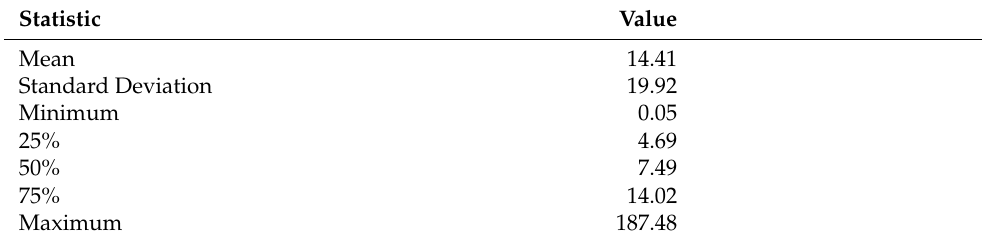
Table 4. Description of Forecasting Errors.